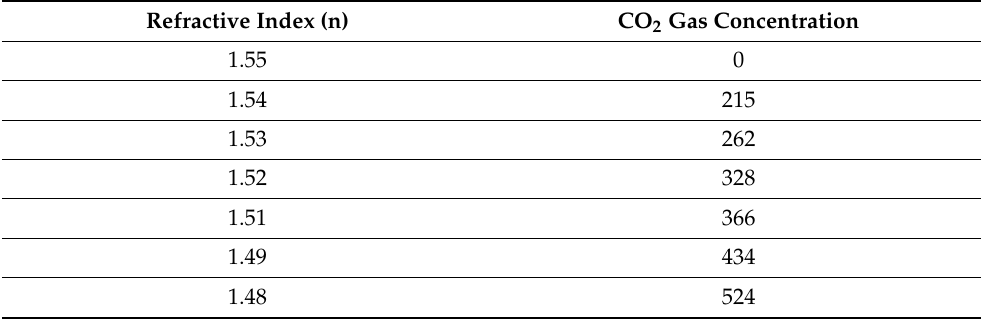
Table 2. Refractive index values of the PHMB functional layer for different concentrations of the CO 2